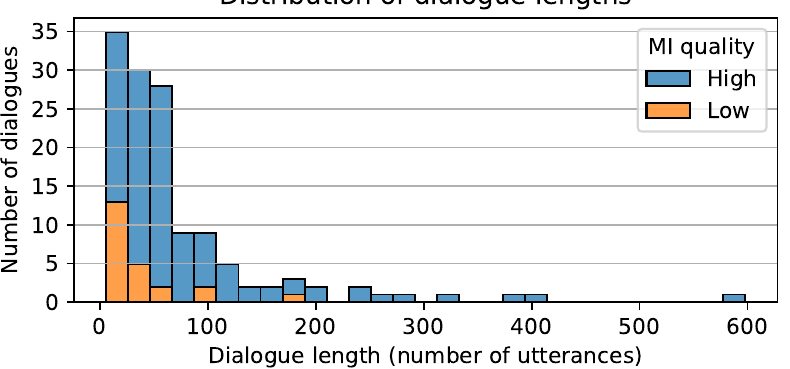
Figure 1. Distribution of dialogue lengths (number of utterances per